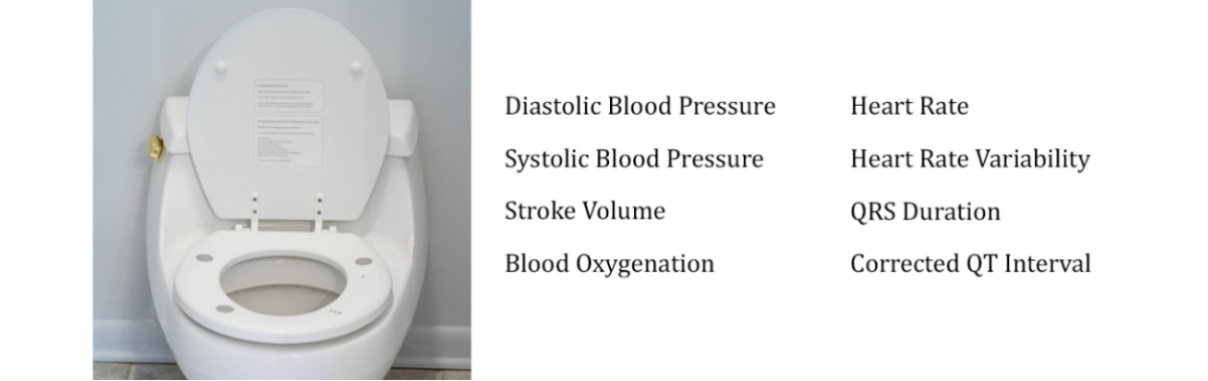
Figure 1. A toilet seat–based cardiovascular monitoring system (left) is integrated into an individual’s daily routine without requiring any change in habit, thereby addressing patient adherence. The system captures a comprehensive set of clinically relevant measurements automatically (right).